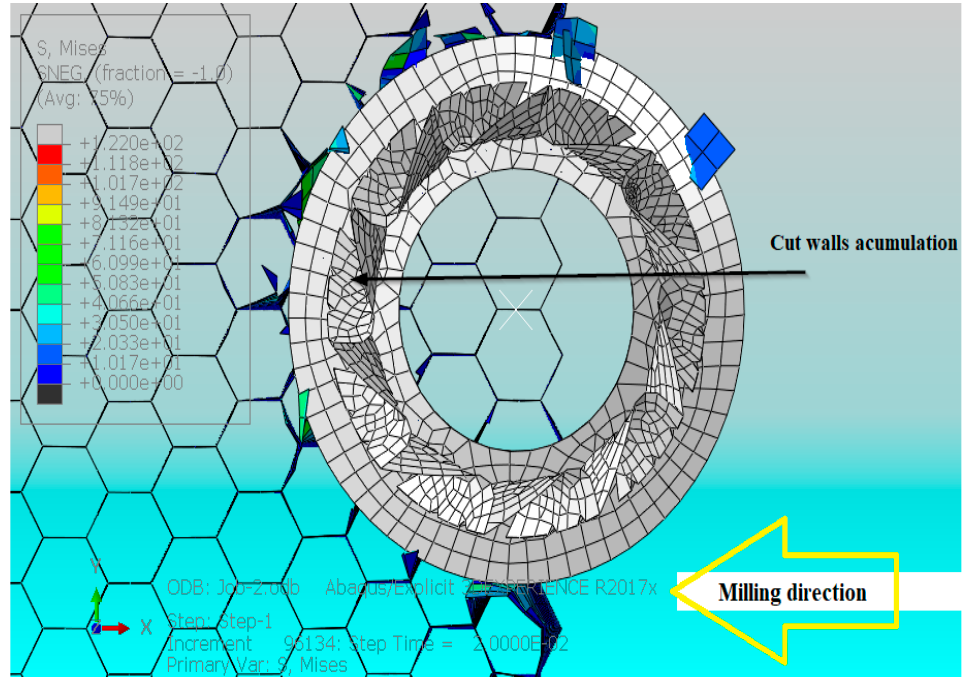
Figure 21. Accrual of material in the face of the cutting tool; wedge angle of the cutting blade is β n = 15°.